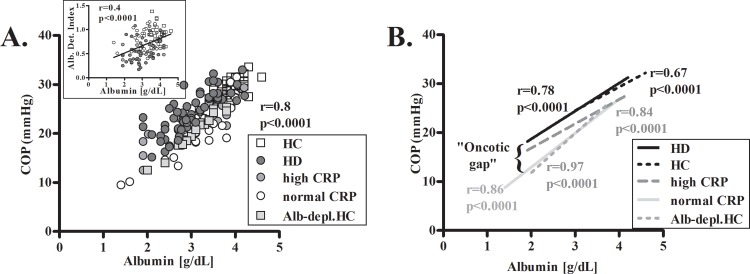
Albumin levels and COP values in the study groups.Sera samples from HC, proteinuria patients with low or high degree of inflammation (normal CRP. and high CRP, respectively), HD patients and HC sera after partial albumin depletion (Alb-depl.HC) were used for determination of albumin levels by BCG and measurements of COPCOP values were correlated with albumin levels measured by BCG in sera of all subjects (A). The separate regression lines are given for each subjects' group and for HC sera after partial albumin depletion (Alb-depl.HC) (B). The BCG-measured albumin levels were also correlated with the albumin detection index (insert in Fig 1A).